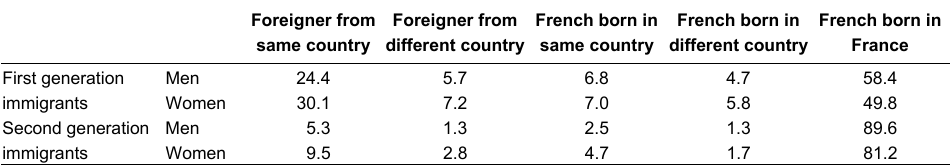
Table 3: Spouse’s nationality and country of birth